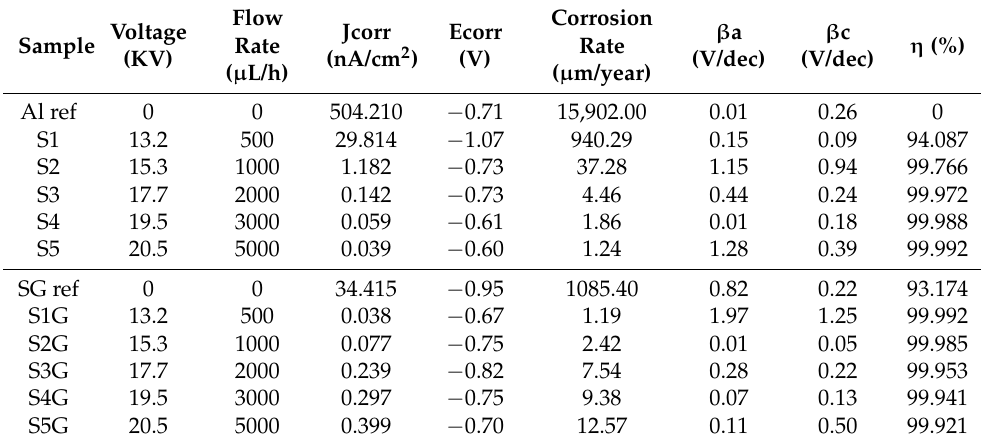
Table 3. Summary table of the Tafel analysis for uncoated aluminum substrate (7075-T6) and coated PVDF-HFP electrospun coatings, which correspond to Figure 14b (Sx) and Figure 14d (SxG). All the samples of this study have been tested in 6 wt% NaCl aqueous